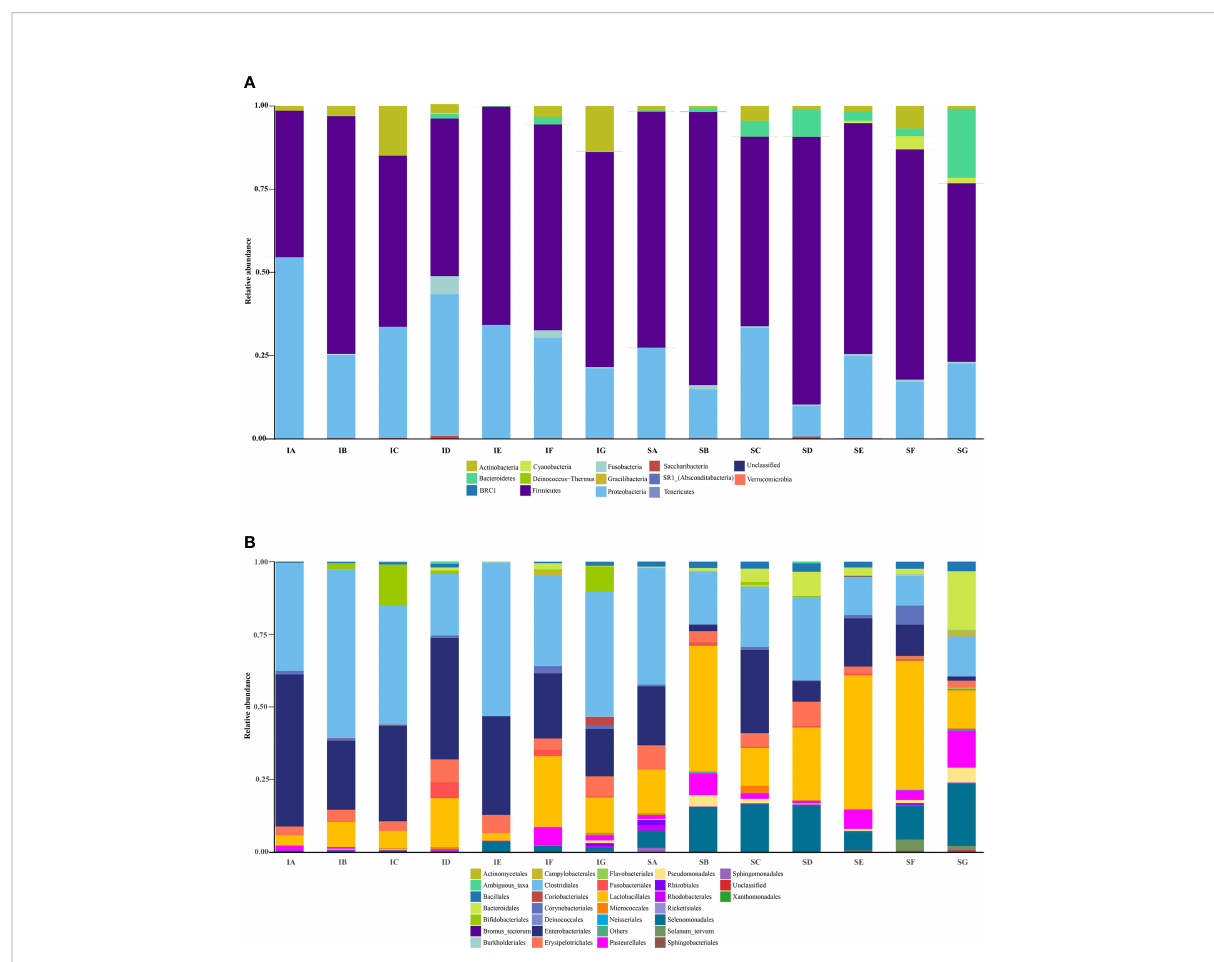
FIGURE 2 The bacterial taxonomic composition of ileum (IA-IG) and stomach (SA-SG) samples from the seven diets at the phyla (A) and order level (B) . SA, control; SB, CpGui10; SC, CpGui15; SD, CpGui20; SE, CpP10; SF, CpP15; SG, CpP20; IA, control; IB, CpGui10; IC, CpGui15; ID, CpGui20; IE, CpP10; IF, CpP15; IG,